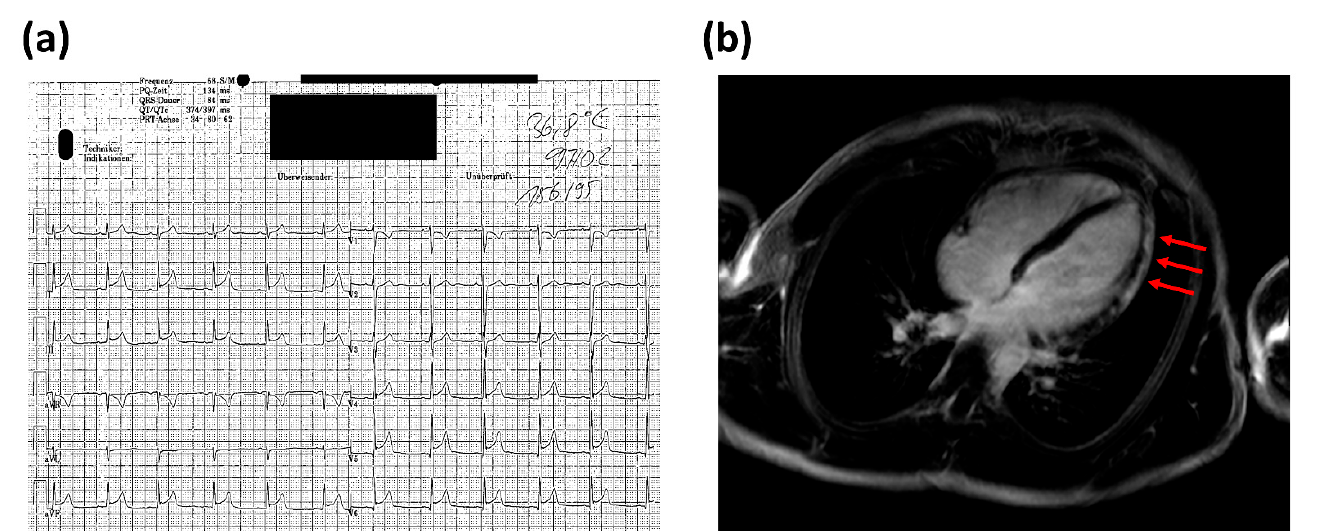
T1-weighted segments of cardiac MRI, subepicardial late enhancement in the area of the apex, as well as the anterolateral wall became